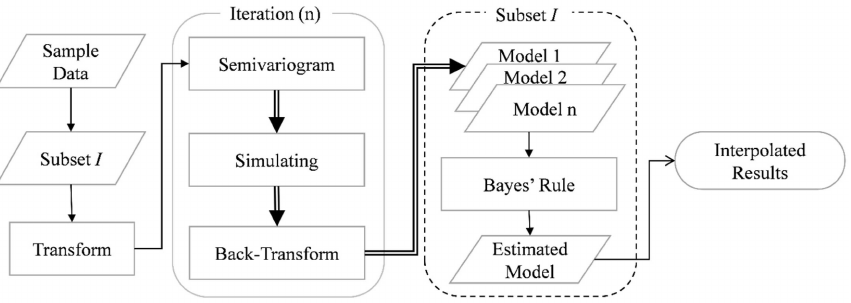
Figure 2. Procedures of empirical Bayesian kriging